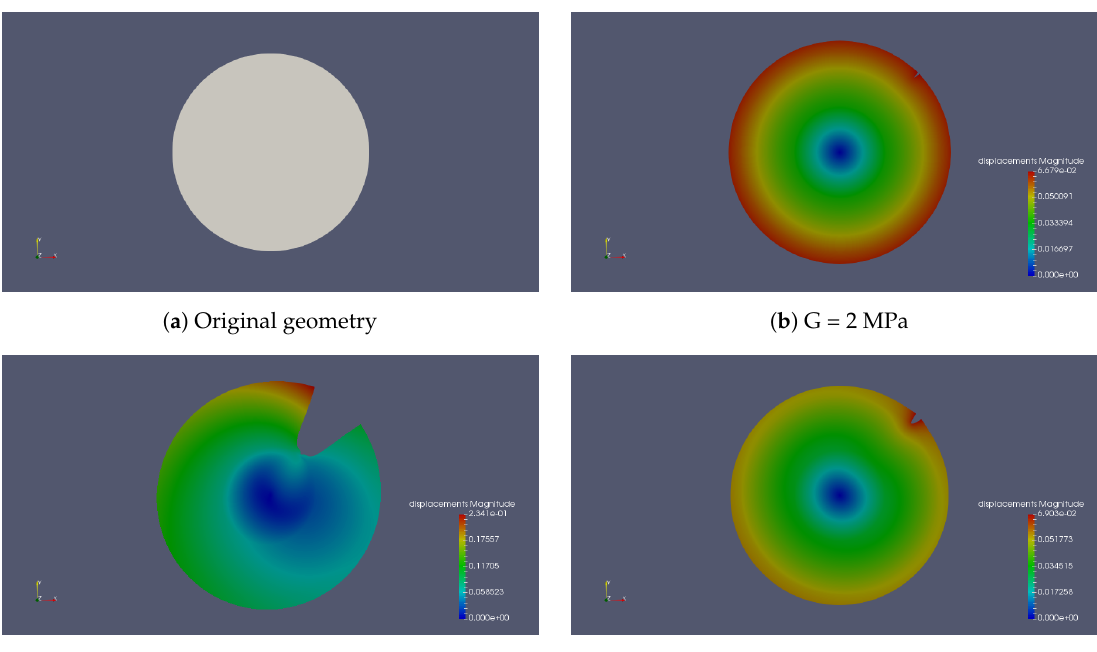
Figure 3. Crack propagation profile over time with different ultimate strengths of the shell.